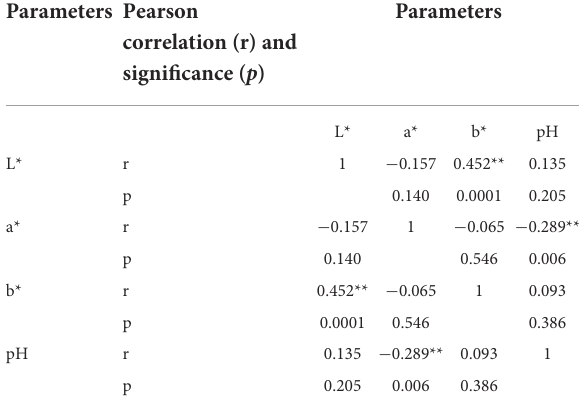
TABLE 2 Correlations between the color coordinates (L * = lightness; a * = redness; –a * = greenness; b * = yellowness; –b * = blueness) and pH of the algae extracts and algae extracts × LUHS135